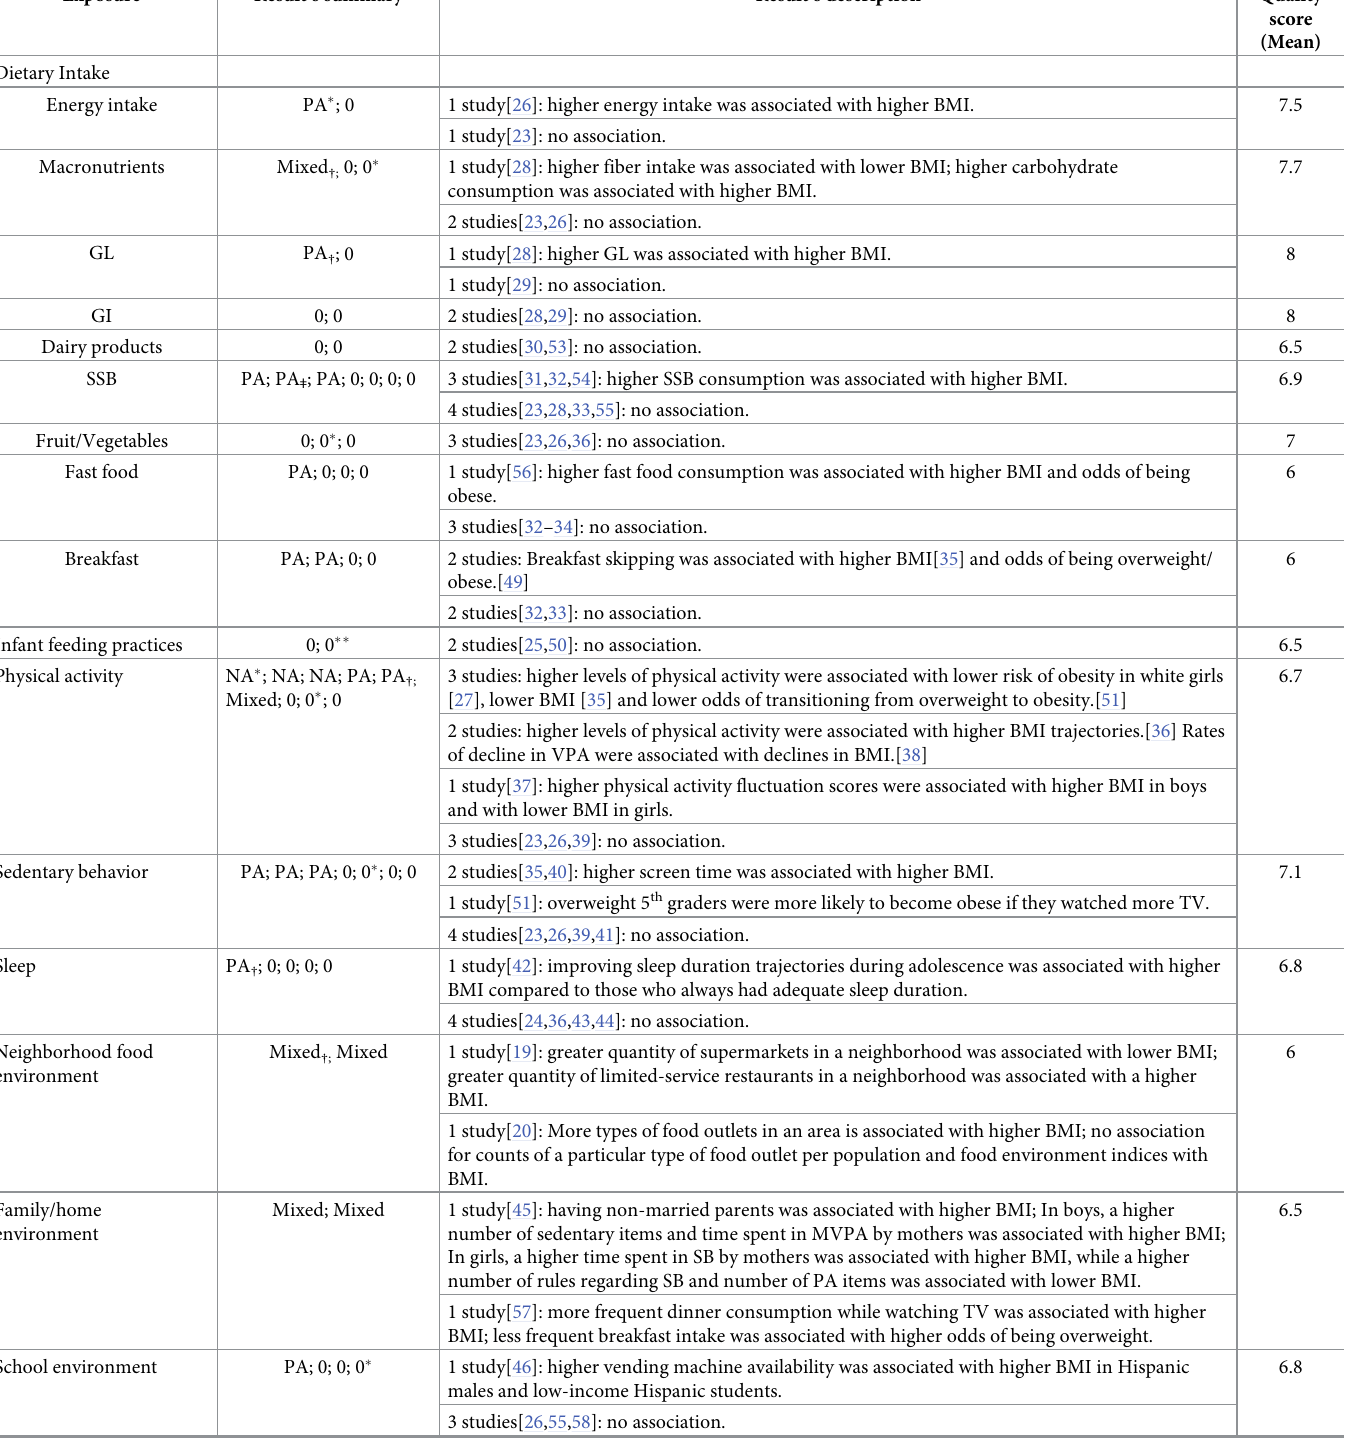
Table 2. Summary of studies included in the review.